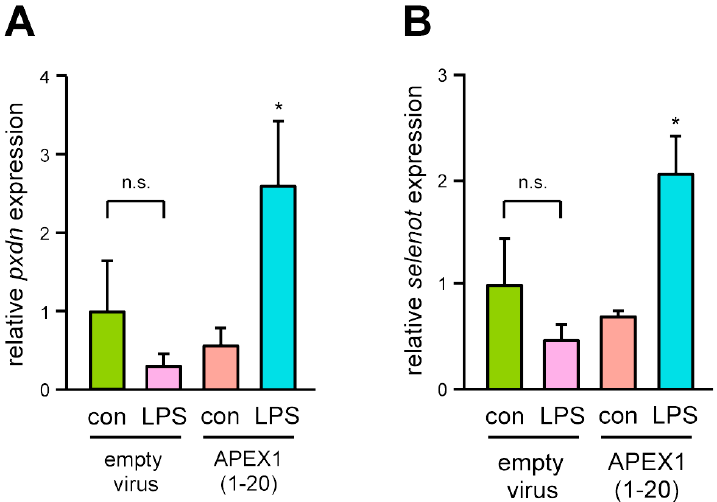
Figure 2. LPS induces upregulation of PXDN and SELENOT expression specifically in EC expressing APEX1(1-20). Transcript levels of PXDN ( A ) and SELENOT ( B ) in EC transduced with an empty virus or the expression vector for APEX1(1-20) and treated with 150 ng/mL detoxified (con) or active LPS (LPS) for 18 h were analyzed by semi-quantitative real-time PCR; RPL32 served as reference (data are mean ± SEM, n = 4, * p < 0.05 vs. APEX1(1-20)/con, n.s. = not significant, one-way ANOVA with post-hoc Tukey LSD test).